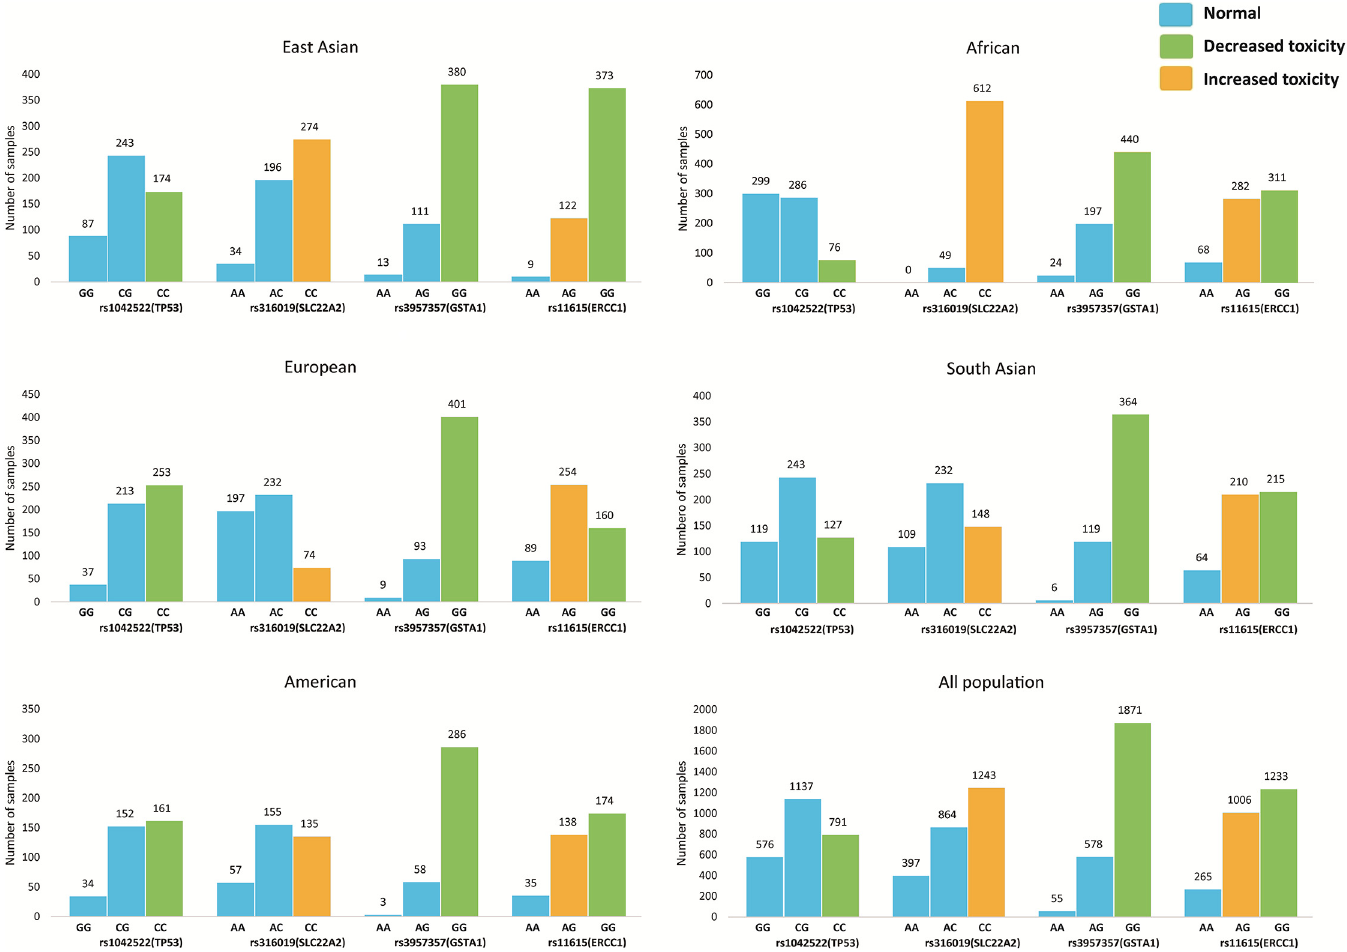
Fig 4. Allele variants of cisplatin-related SNPs and their impacts on cisplatin toxicity. Statistical frequencies of SNPs rs1042522, rs316019, rs11615, and rs3957357 among five major populations from the 1000 Genomes Project are shown together with their impacts on cisplatin